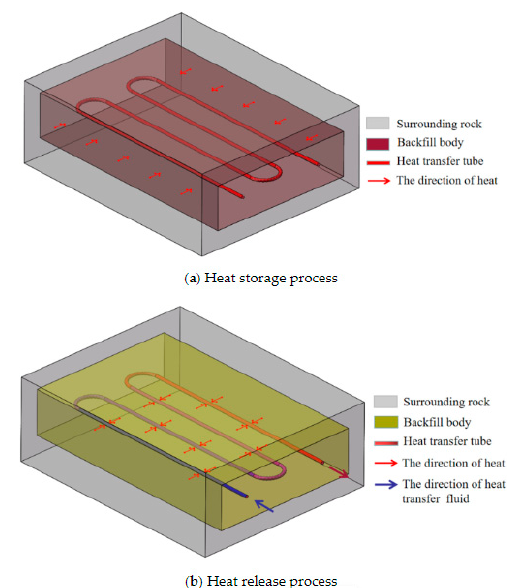
Figure 2. The working process of the phase-change heat storage backfill body.